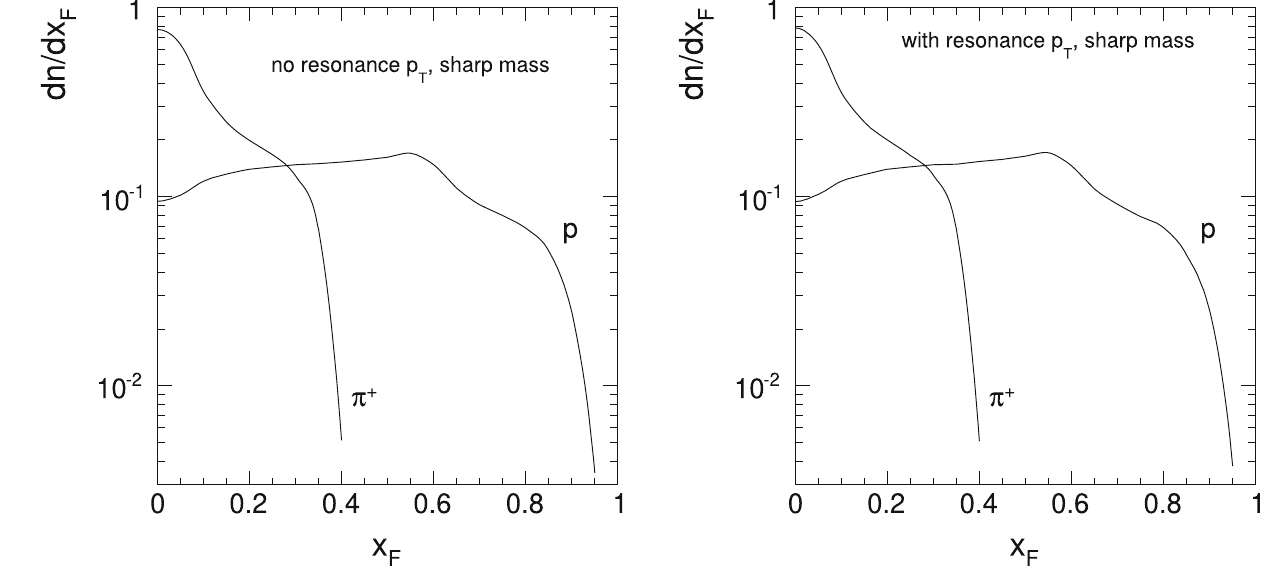
Fig. 152 dn / dx F for decay protons and pions as a function of x F